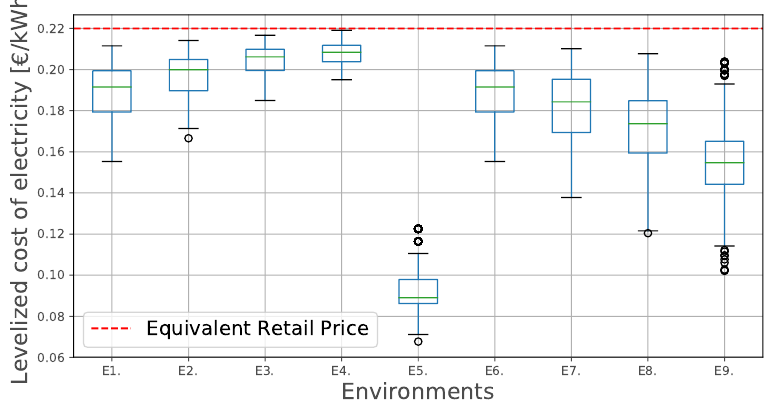
Figure 6. Levelized cost of electricity of the prosumers in set I , for every environment